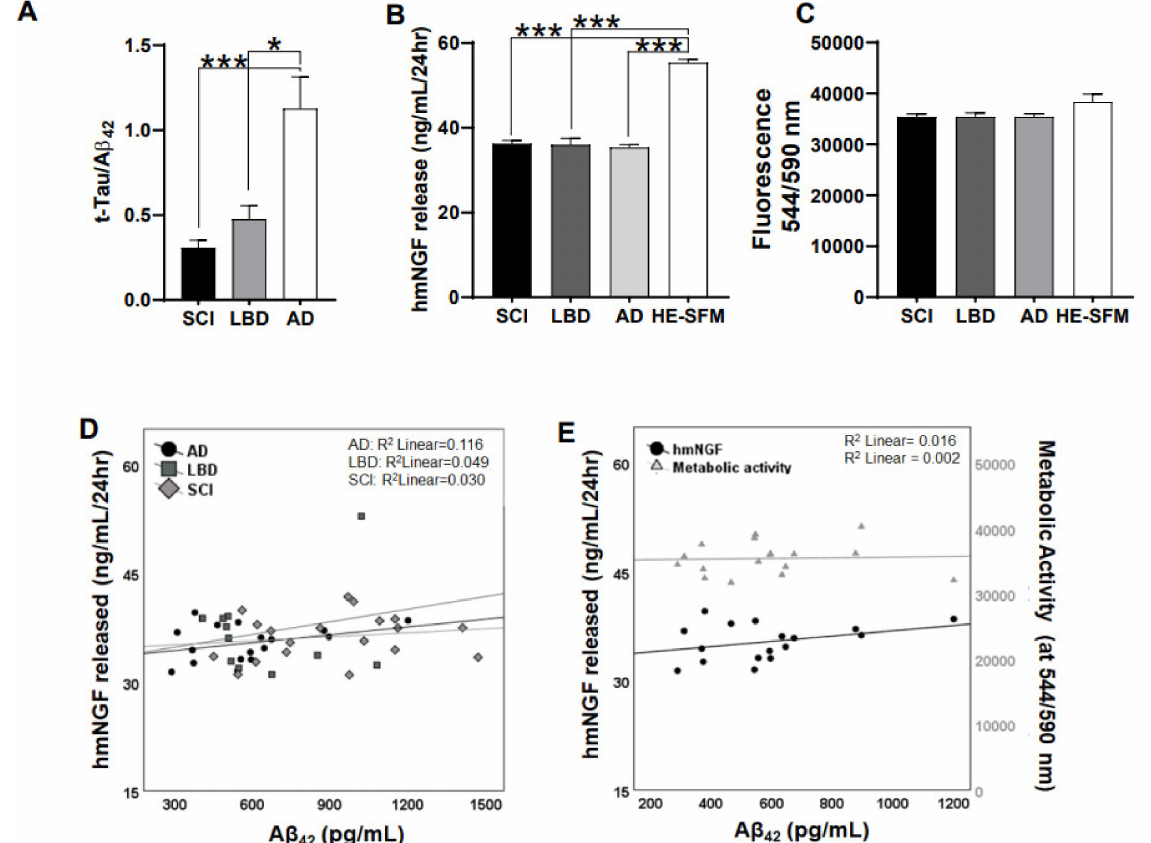
Figure 1. Effect of human CSF on NGC0211 cells. NGC0211 cells (1 × 10 4 cells/well, 96-well plate) were cultured in vitro and exposed to human CSF (AD, SCI, LBD) for 48 h and parameters; hmNGF release and metabolic activity were measured of t-Tau/A β 42 (AD = 20, SCI = 20, LBD = 11) to ascertain pathological segregation of CSF samples. ( B ) After